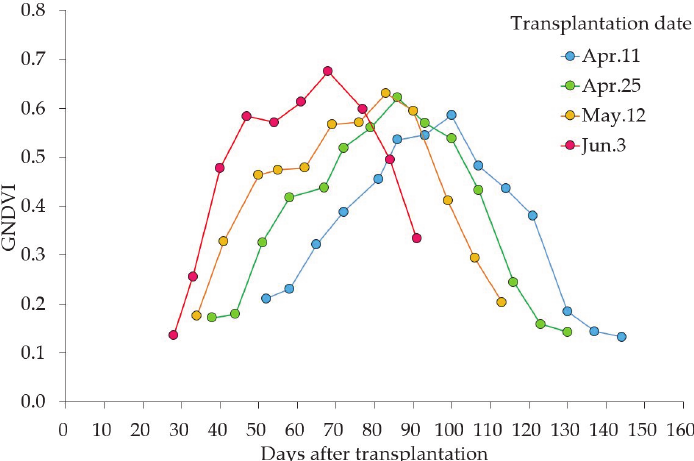
Figure 4. Time series of green normalized vegetation index (GNDVI) in the test site (2016). Green circles and the green line are Koshihikari , red circles and the red line are Fusaotome , and orange circles and the orange line are Fusakogane .